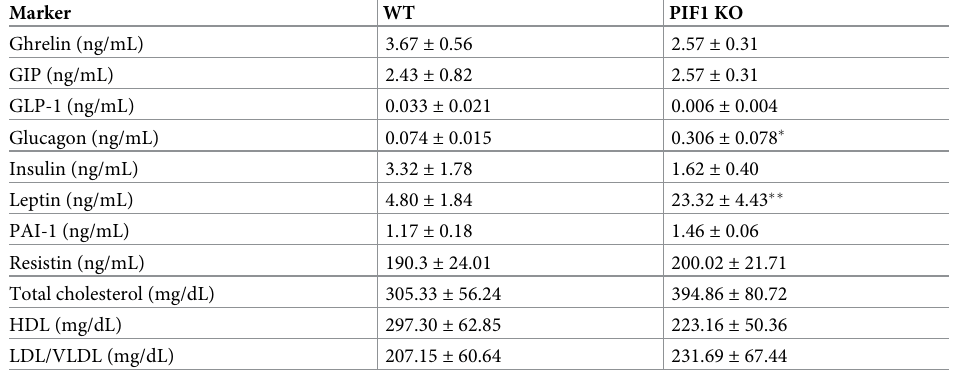
All values are mean ± SEM; n = 3–12 per group; pvalues from Student’s t-test: � p < 0.05 �� p <